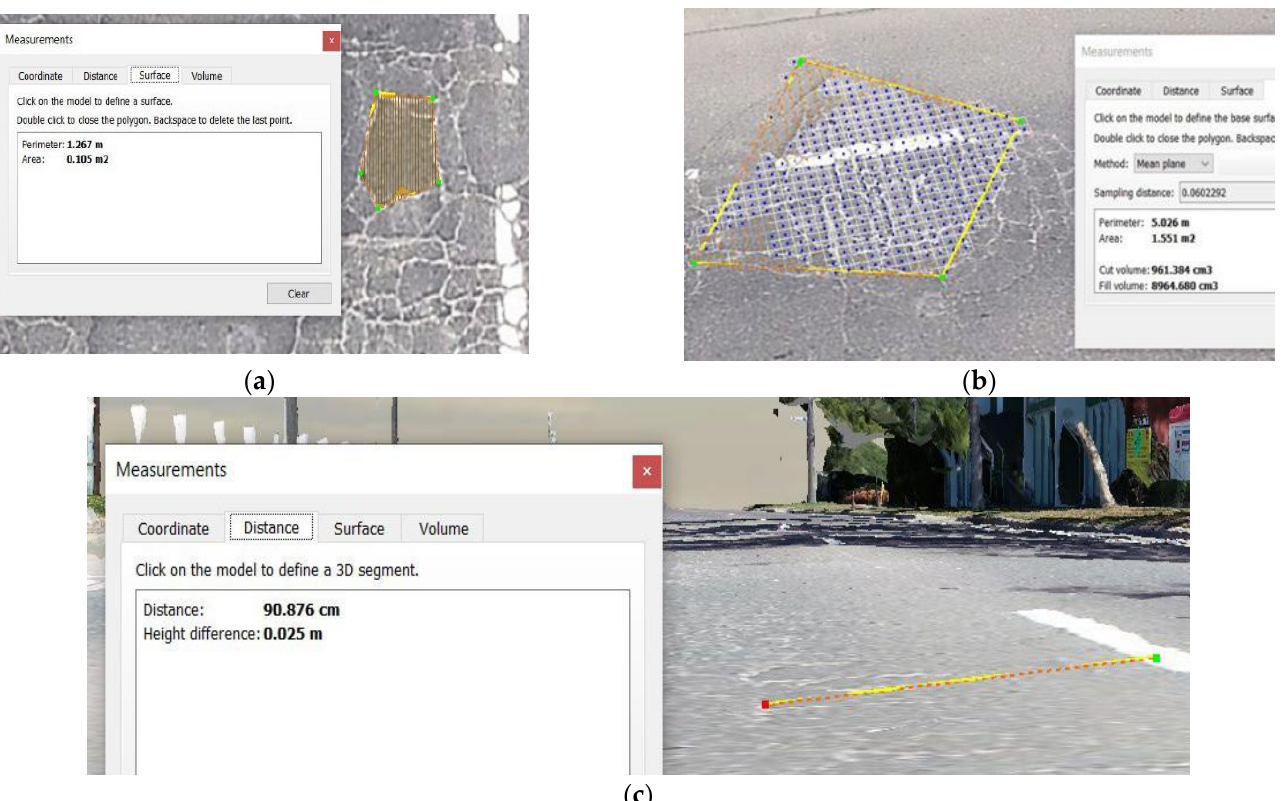
Figure 6. Defects from the reality model: ( a ) crocodile cracking; ( b ) pothole; and ( c ) rutting.